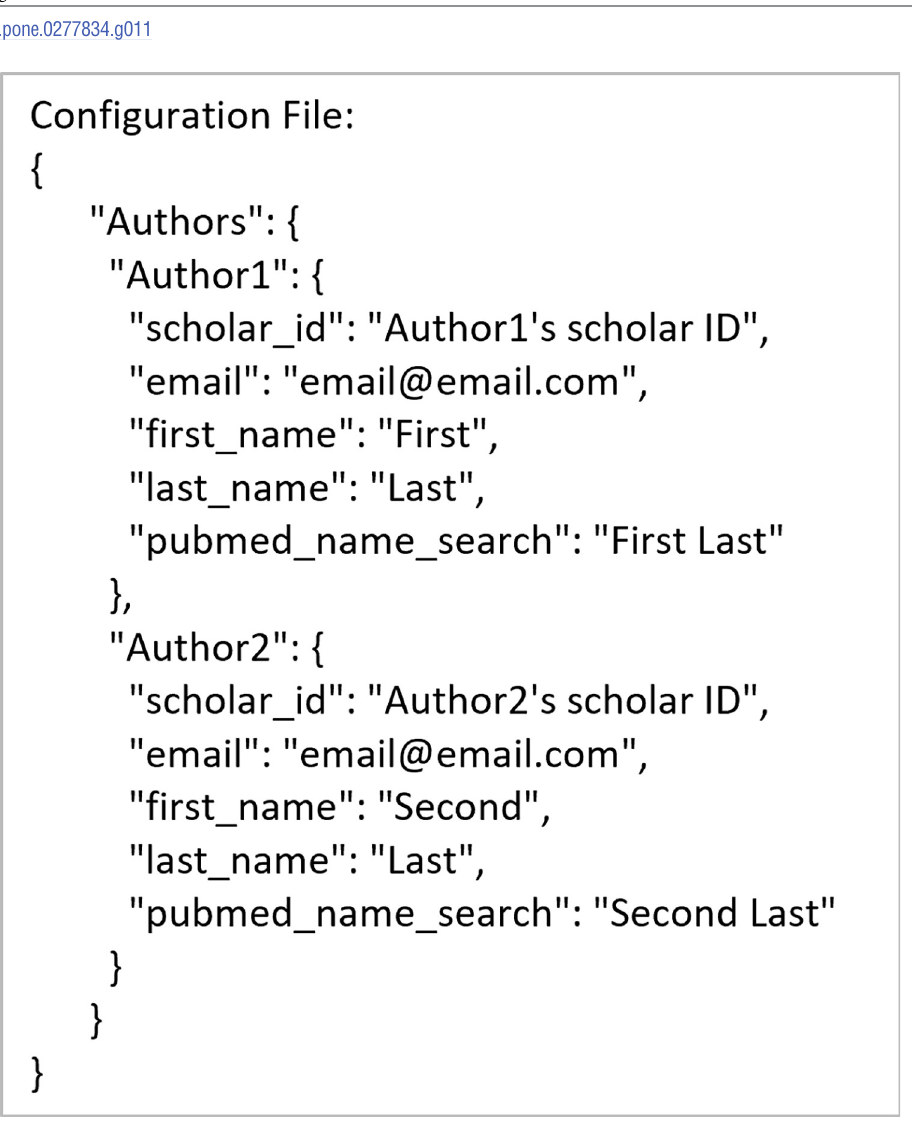
Fig 12. Contents of the output configuration JSON file for the Google Scholar ID search